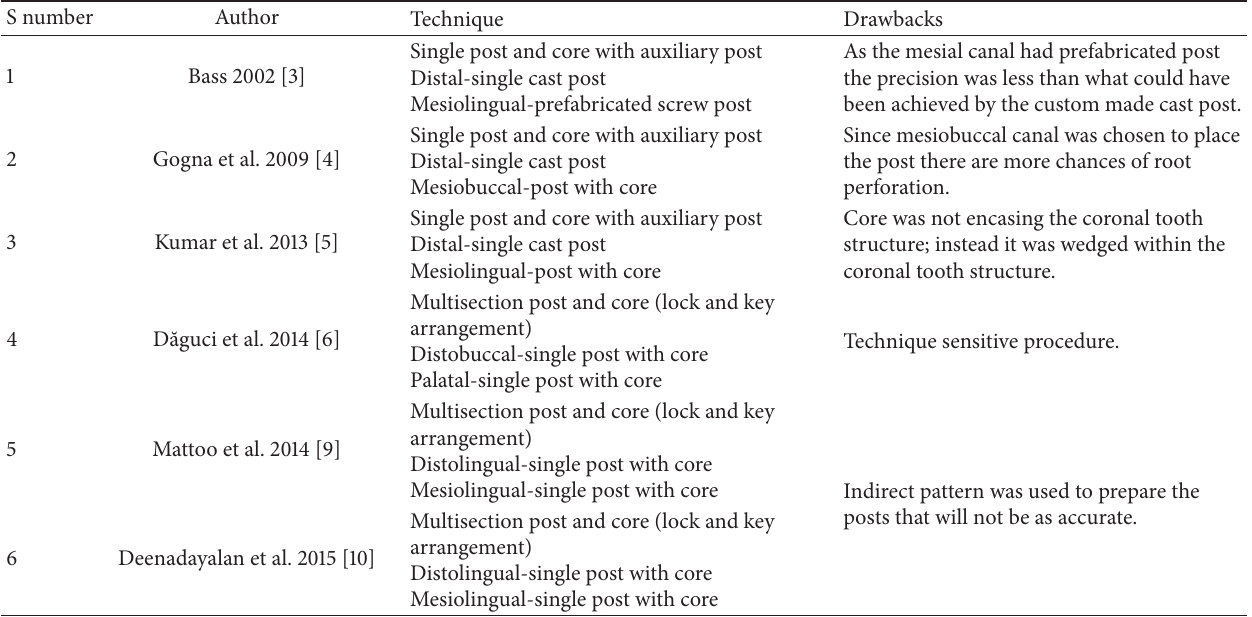
Table 1: Review of